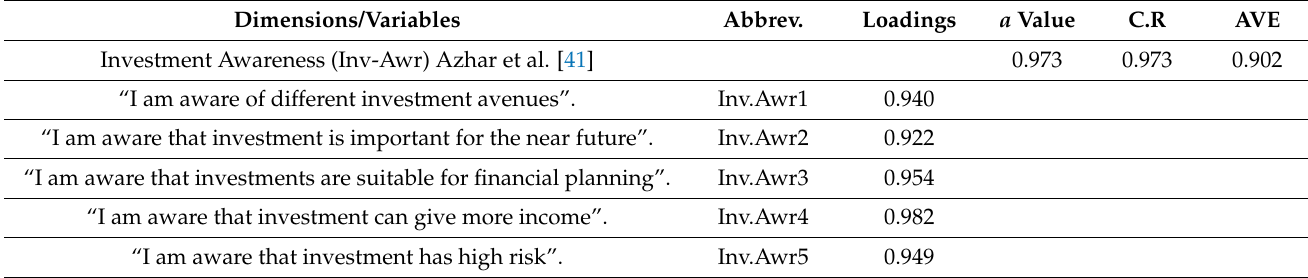
Table 1. Outer model